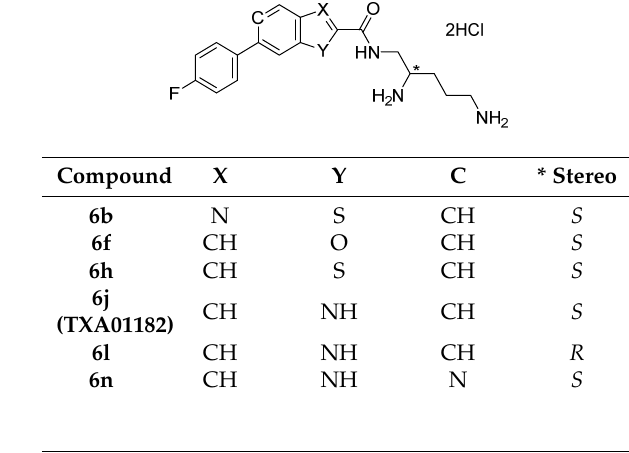
The fused heterocyclic carboxamides were separated into two groups: (1) from zero to weak potentiation (benzothiazole 6a and 6b , and benzimidazole 6c and 6d ) and (2) from moderate to high potentiation (benzothiophene 6g and 6h , indole 6i to 6l ). Although ben- zothiophene compound 6g showed the highest potency (32-fold at 6.25 µg/mL), due to its low MIC, this scaffold was discarded from further screening to maintain the strict guide- line of at least a 12-fold difference in MIC and the screening concentration. The 6-substi- tuted para -fluorophenyl showed better activity than substitution at 5-position of indoles ( 6j vs. 6i; 6l vs. 6k ). Azaindole analogs 6m and 6n completely failed to exhibit potentiation